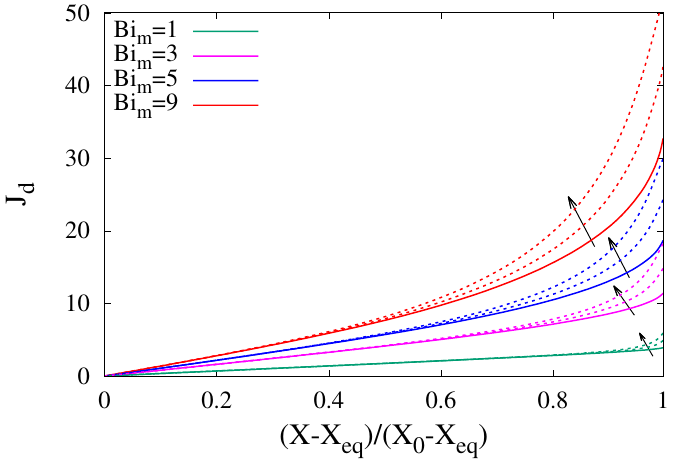
Figure 6. Dimensionless dehydration rate J d vs. moisture ratio X r = ( X − X eq ) / ( X 0 − X eq ) for Bi m = 1,3,5,9 for a uniform initial water distribution, β core two non-uniform initial water distributions (dashed lines), β core values of β 0 , i.e., increasing